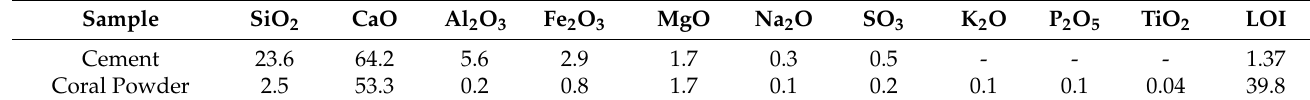
Table 1. Chemical composition of cement and coral powder (%).